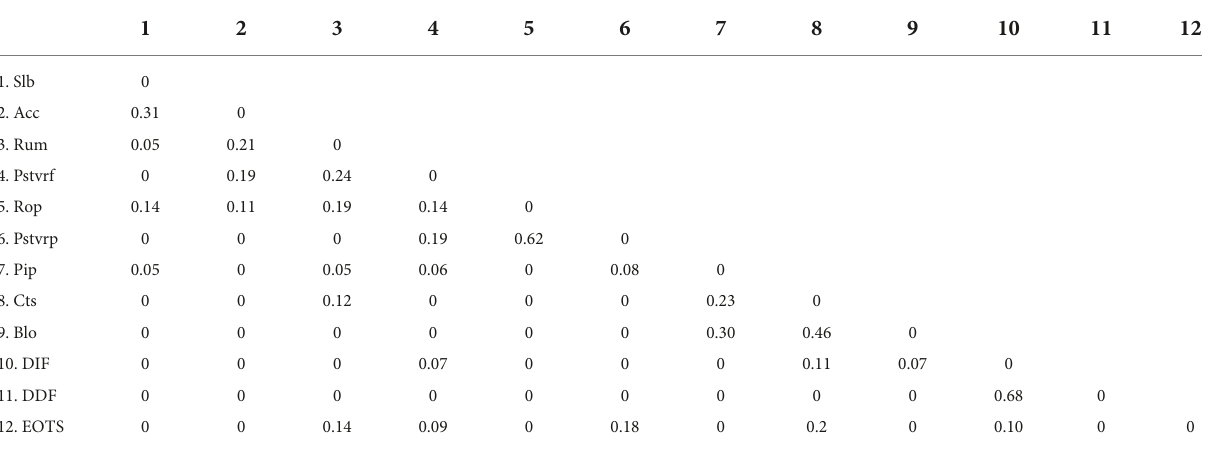
TABLE 1 Weights of the connections in the Graphical Least Absolute Shrinkage and Selection Operator (GLASSO)